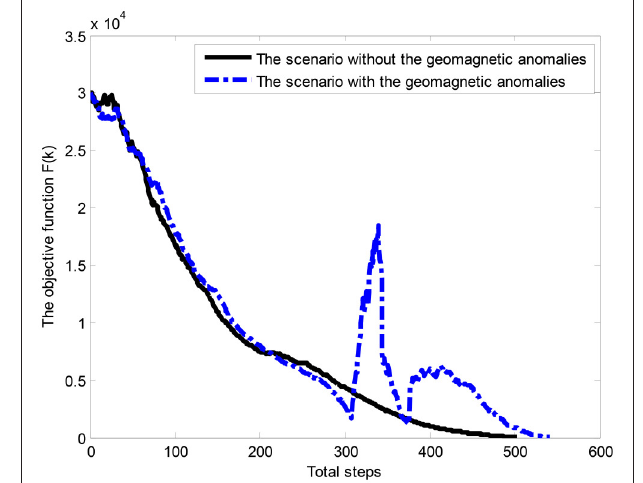
FIGURE 7 | The convergence curves of geomagnetic components within the geomagnetic anomalies.